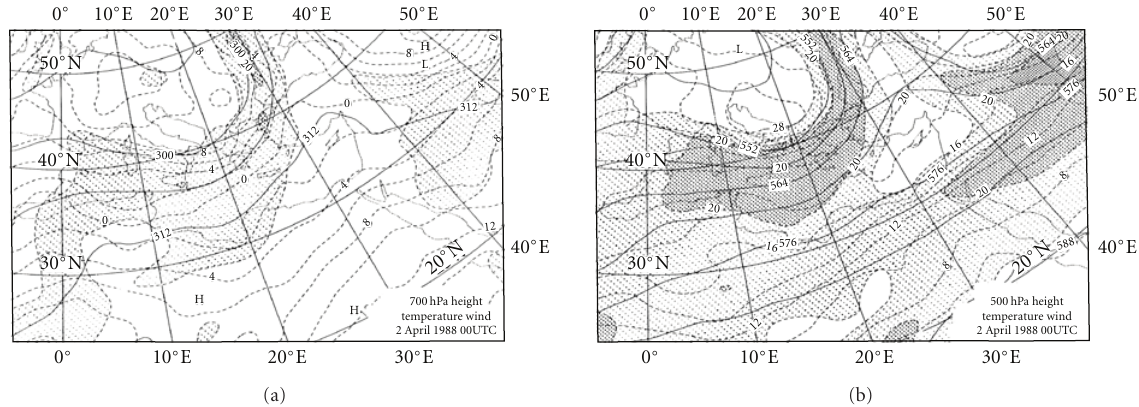
Figure 11: Same as Figures 3(b) and 3(c), but for 00:00 UTC on 2 April 1988, (a) 700 hpa and (b) 500hpa.